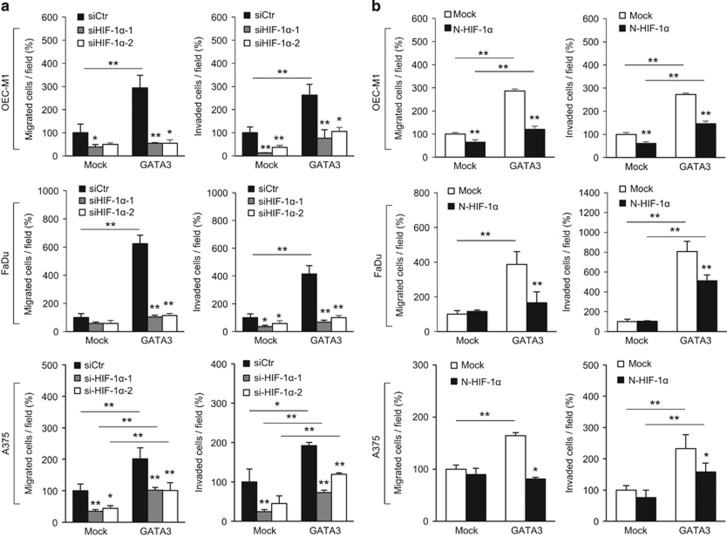
GATA3-mediated cancer cell invasiveness is reversed by HIF-1α knockdown or N-HIF-1α expression. (a) Effects of HIF-1α knockdown on migration and invasion in OEC-M1, FaDu and A375 cells overexpressing GATA3. Mock or GATA3 overexpressing OEC-M1, FaDu and A375 stable transfectants were transiently transfected with non-targeting siRNA (siCtr) or two independent siRNAs against HIF-1α (siHIF-1α-1, siHIF-1α-2). Transwell migration and Matrigel invasion assays were carried out under hypoxia. (b) Effects of the ectopic N-HIF-1α expression on GATA3-mediated migration and invasion. Mock or GATA3 overexpressing OEC-M1, FaDu and A375 stable transfectants were transfected with empty vector (Mock) or N-HIF-1α/pCMV-Tag 4A (N-HIF-1α). Transwell migration and Matrigel invasion assays were carried out under hypoxia. The results are represented as mean±s.d. from three independent experiments. *P<0.05, **P<0.01.